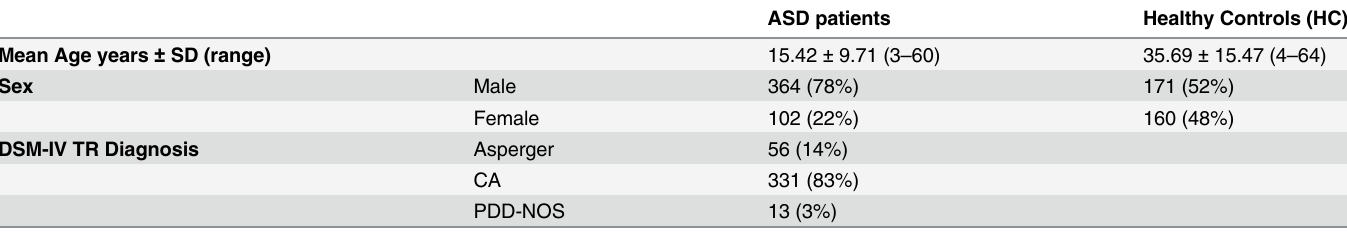
Table 1. Demographic and clinical data of ASD patients and healthy controls.